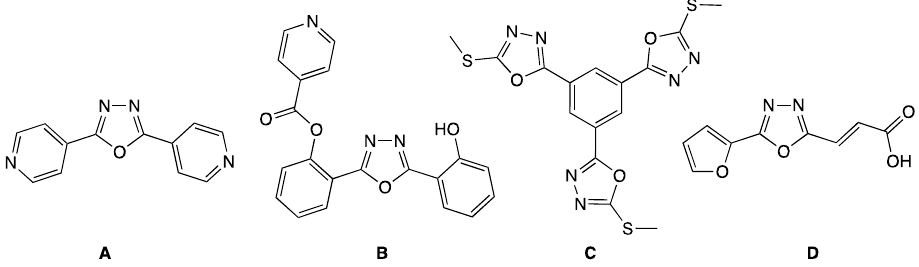
Figure 1. Examples of 1,3,4 ‐ oxadiazole ‐ containing ligands A – D used in silver(I)